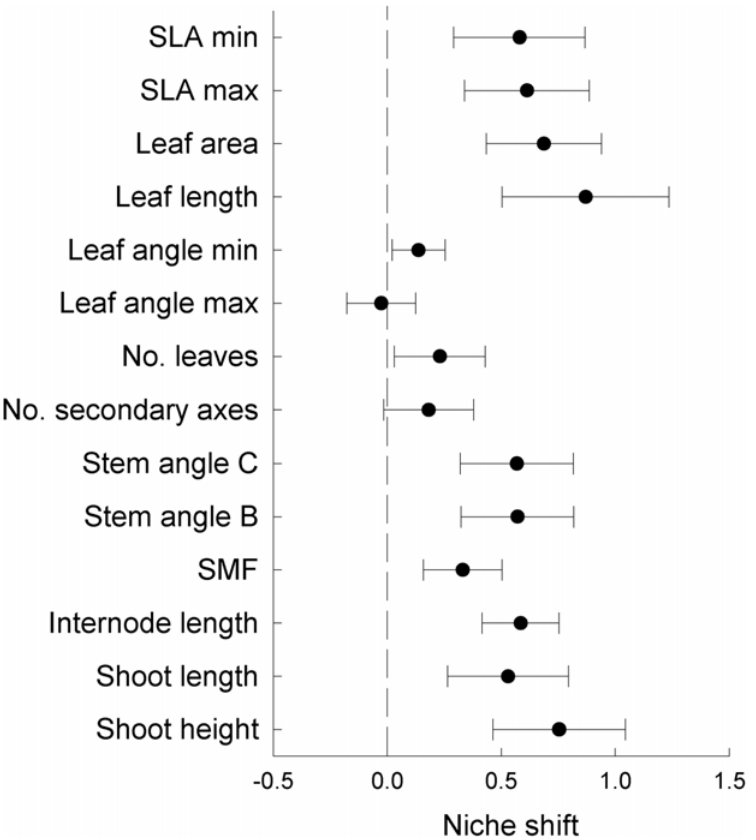
Fig 4. Niche shifts of legume species from monoculture to mixture. Niche shift was quantified as within- species trait distances of monoculture to mixture individuals and compared to within-species trait distances of monoculture individuals and is shown as log-response ratio. Euclidean distances were calculated based on standardized trait data. Values are means across species ± 1 SE. Positive values indicate that species shifted their niches in mixture compared to niche use in